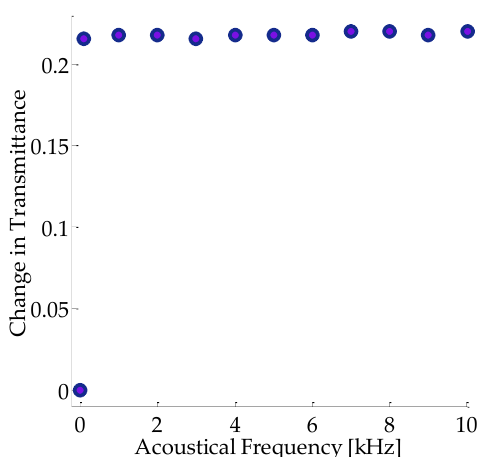
Figure 5. Experimental results describing the change in optical transmittance vs. frequency of acoustical waves in propagation through the sample studied. The optical signals were provided by nanosecond pulses at a wavelength of 532 nm.